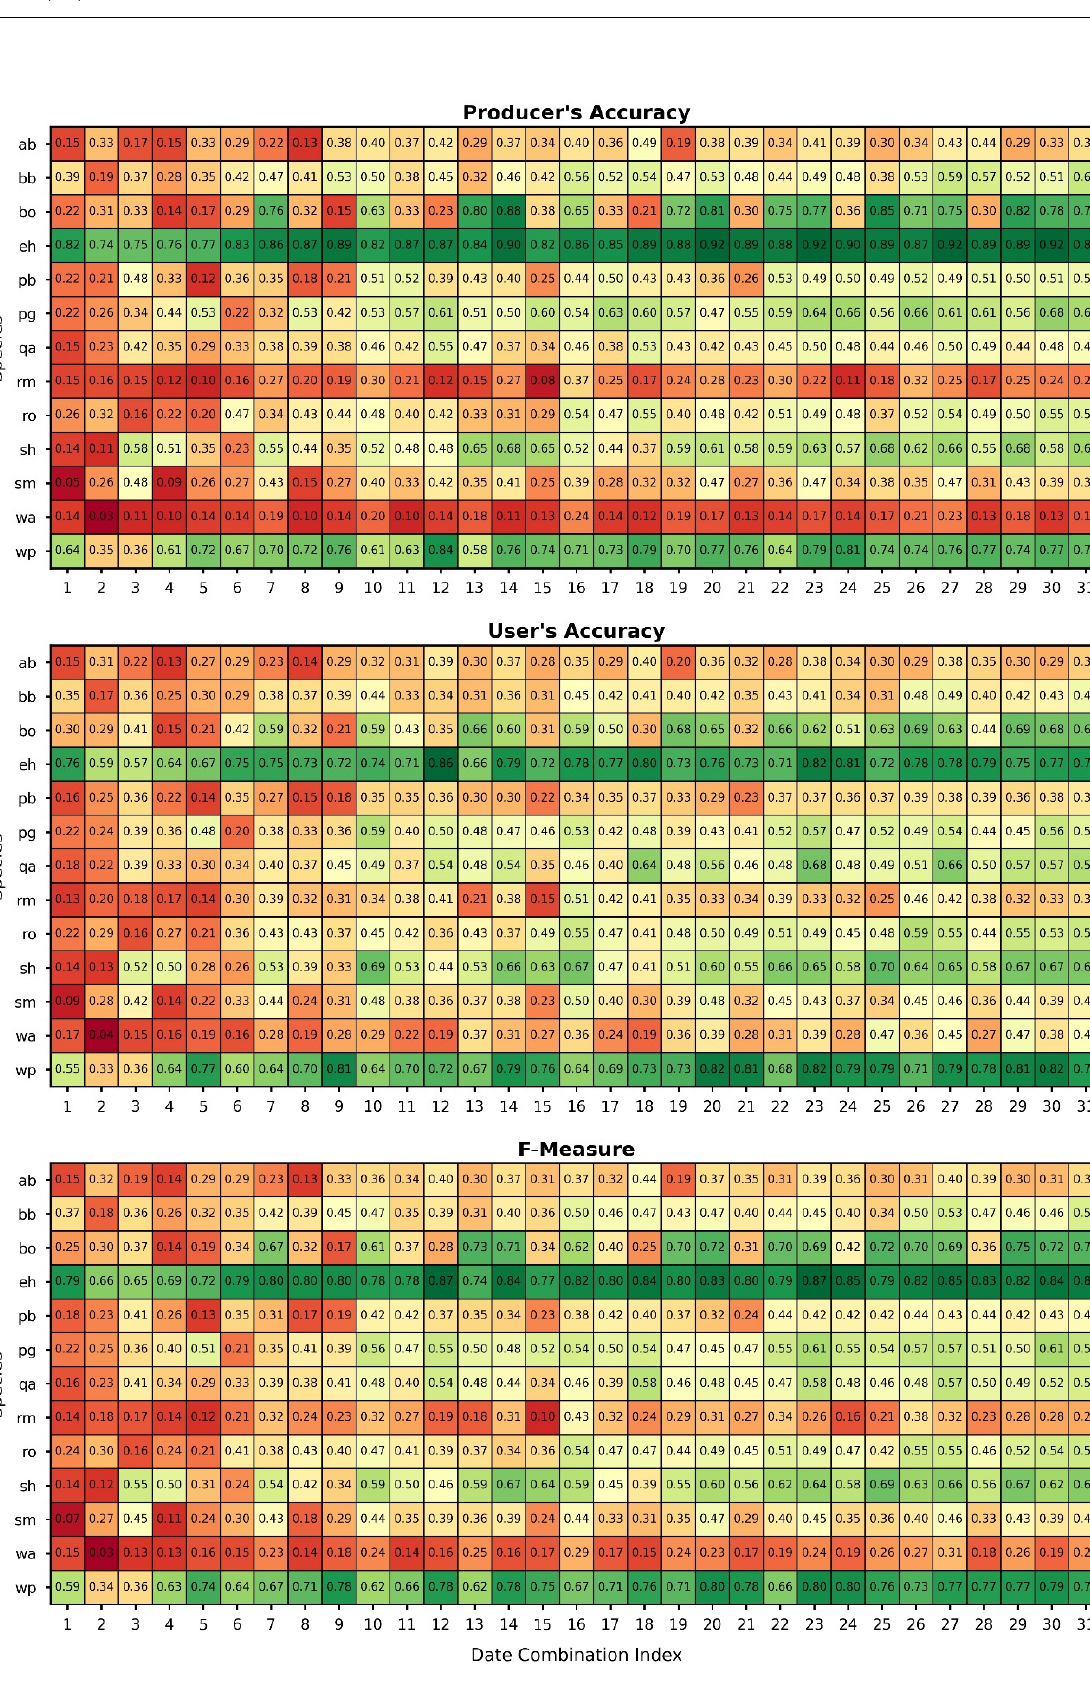
Figure 4. Producer’s accuracy, user’s accuracy, and F-measure for all Sequoia classifications. The values on the x-axis are the index values assigned to each classification (see Table 3). The y-axis is the species abbreviation (see Table 2).